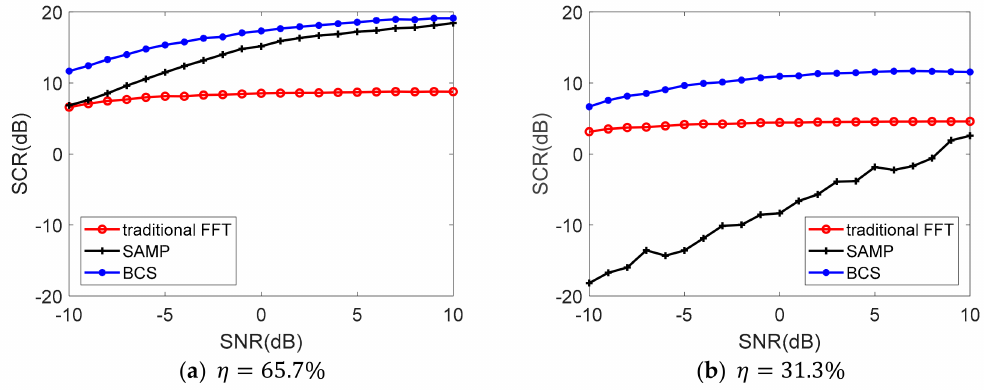
Figure 5. The SCR versus di ff erent SNR of the echo